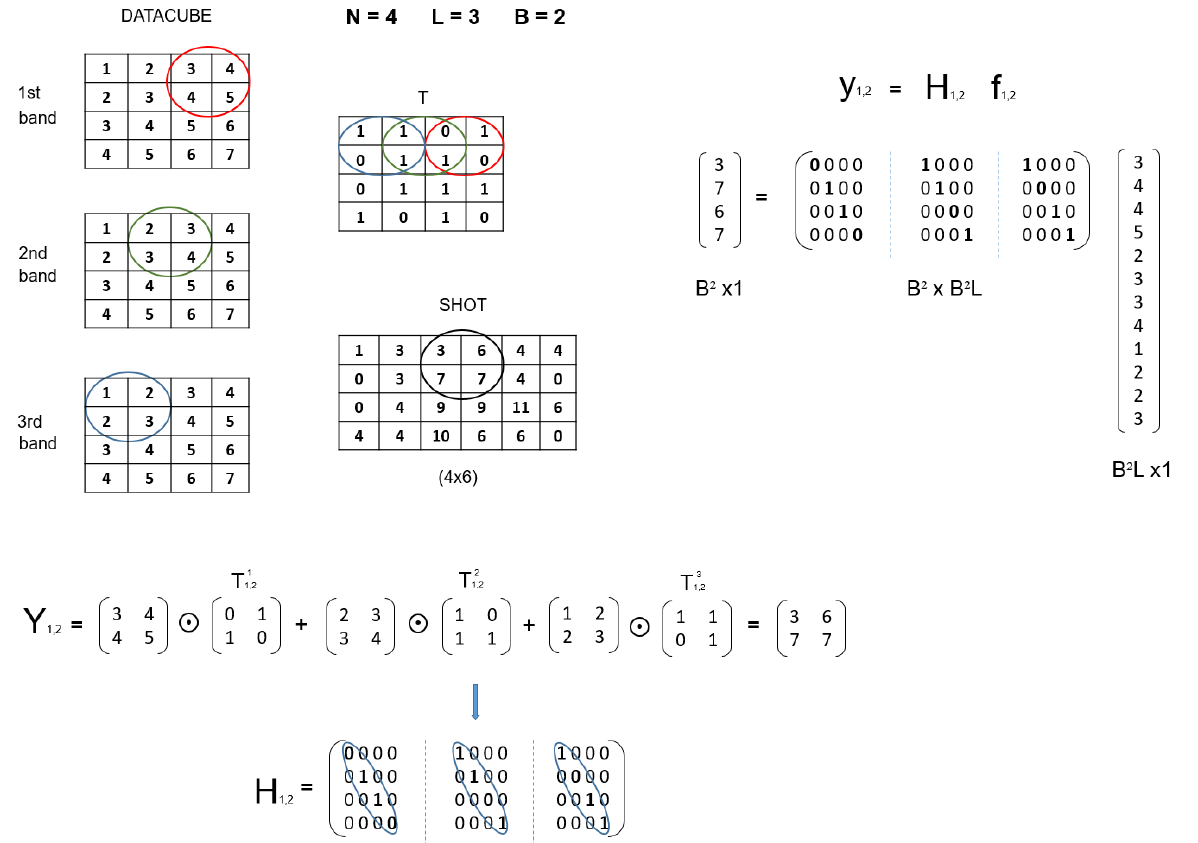
Figure 5. Example to illustrate the construction of the matrices H m , n in the block CASSI